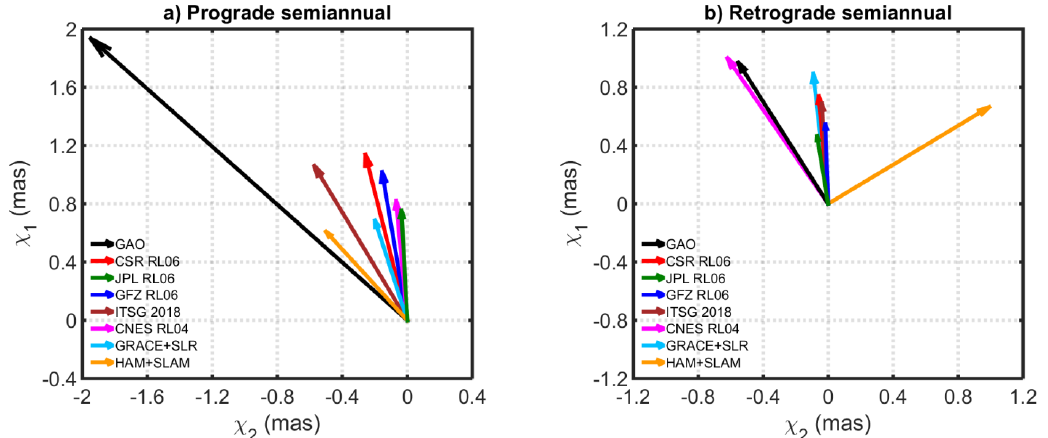
Figure 9. Phasor diagrams of prograde and retrograde semi-annual variation in χ 1 + iχ 2 for GAO, GSMAM, GRACE + SLR, and HAM + SLAM. Phase φ of the oscillation is defined by the semi-annual term as sin(4π(t − t 0 ) + φ), where t 0 is the reference epoch (1 January 2004). To analyze the agreement between non-seasonal GSMAM, GRACE + SLR, HAM + SLAM and